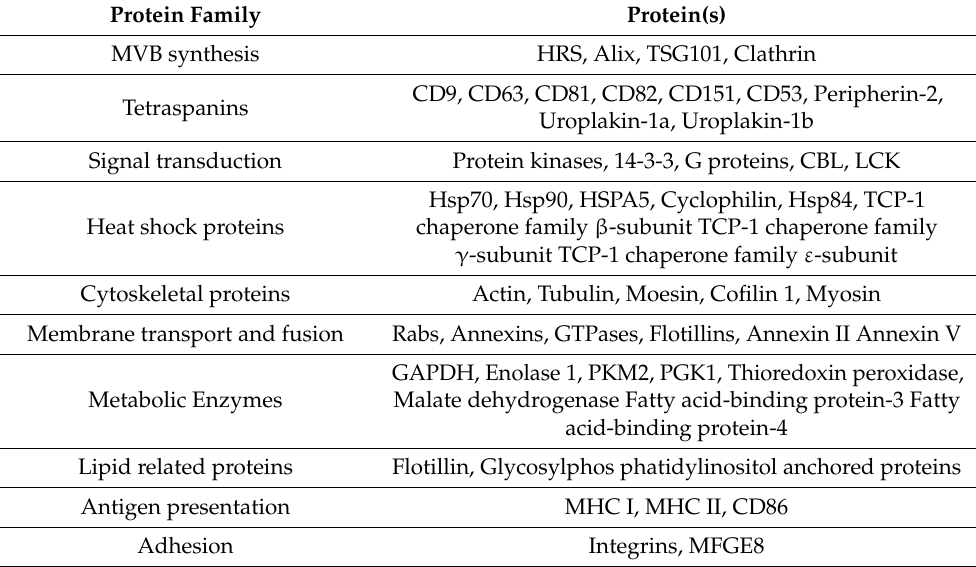
Table 2. Typical protein families found within EVs